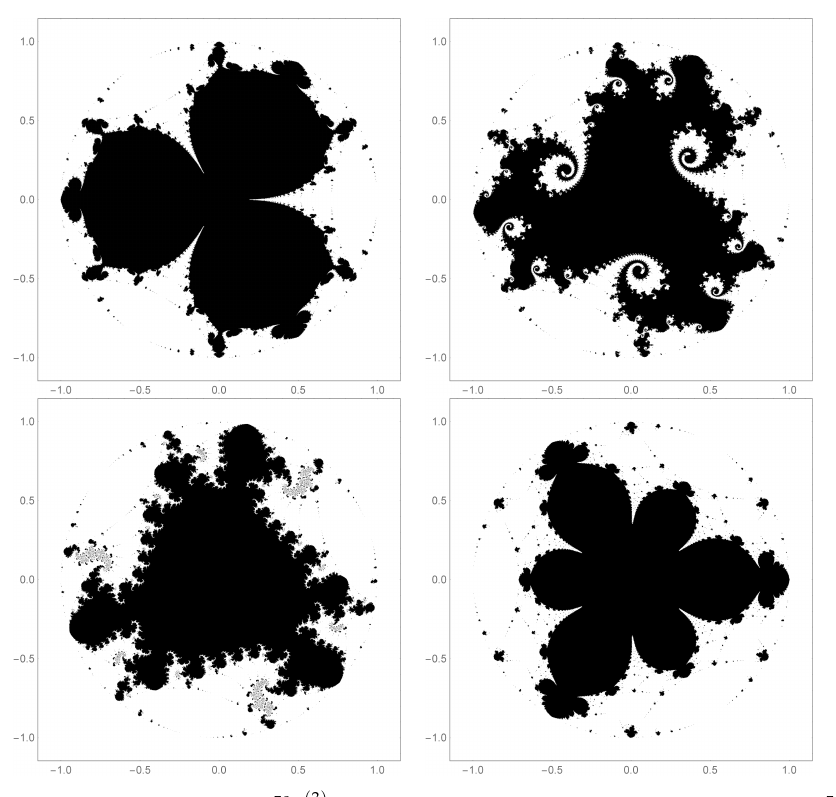
( z ) . 30 ( 3 ) ( z ) . The bottom left 30